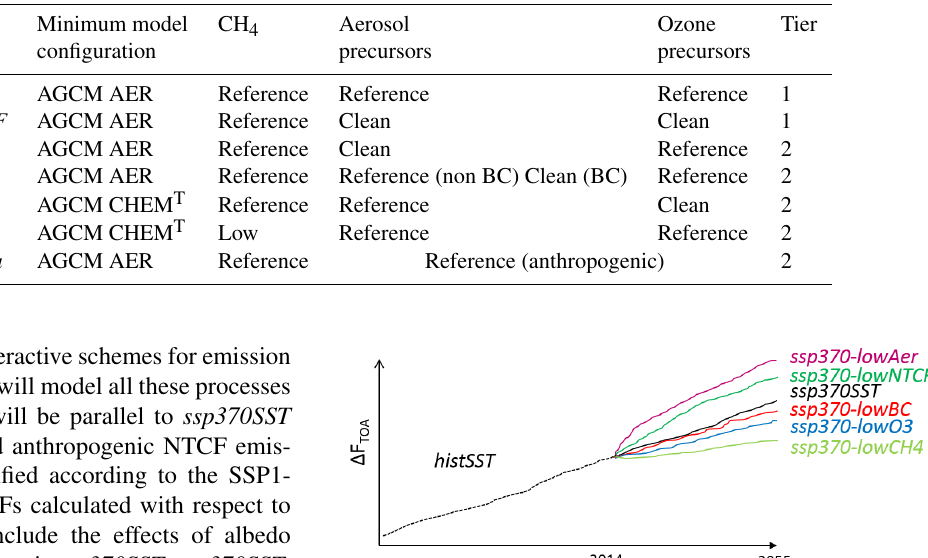
Table 5. List of future prescribed SST simulations. Experiments cover the period 2015 to 2055. The “AER” suffix means models should at least calculate tropospheric aerosols driven by emission fluxes. The “CHEM T suffix means that at least interactive tropospheric chemistry is required. Models should always be run with the maximum complexity available. The species columns refer to the specifications for concentrations (CH 4 ) or emissions (aerosol and ozone precursors). “Reference” means the concentrations or emissions should evolve as for SSP3-7.0; “Clean” means the concentrations or emissions should evolve following a version of SSP3-7.0 with cleaner air quality policies. CFC/HCFC concentrations should follow the SSP3-7.0 scenario in all cases. For ssp370SST-lowLu the land-use mask from the SSP1-2.6 scenario should be used for the interactive natural emission schemes (and for the climate); anthropogenic emissions should follow the SSP3- 7.0 scenario.